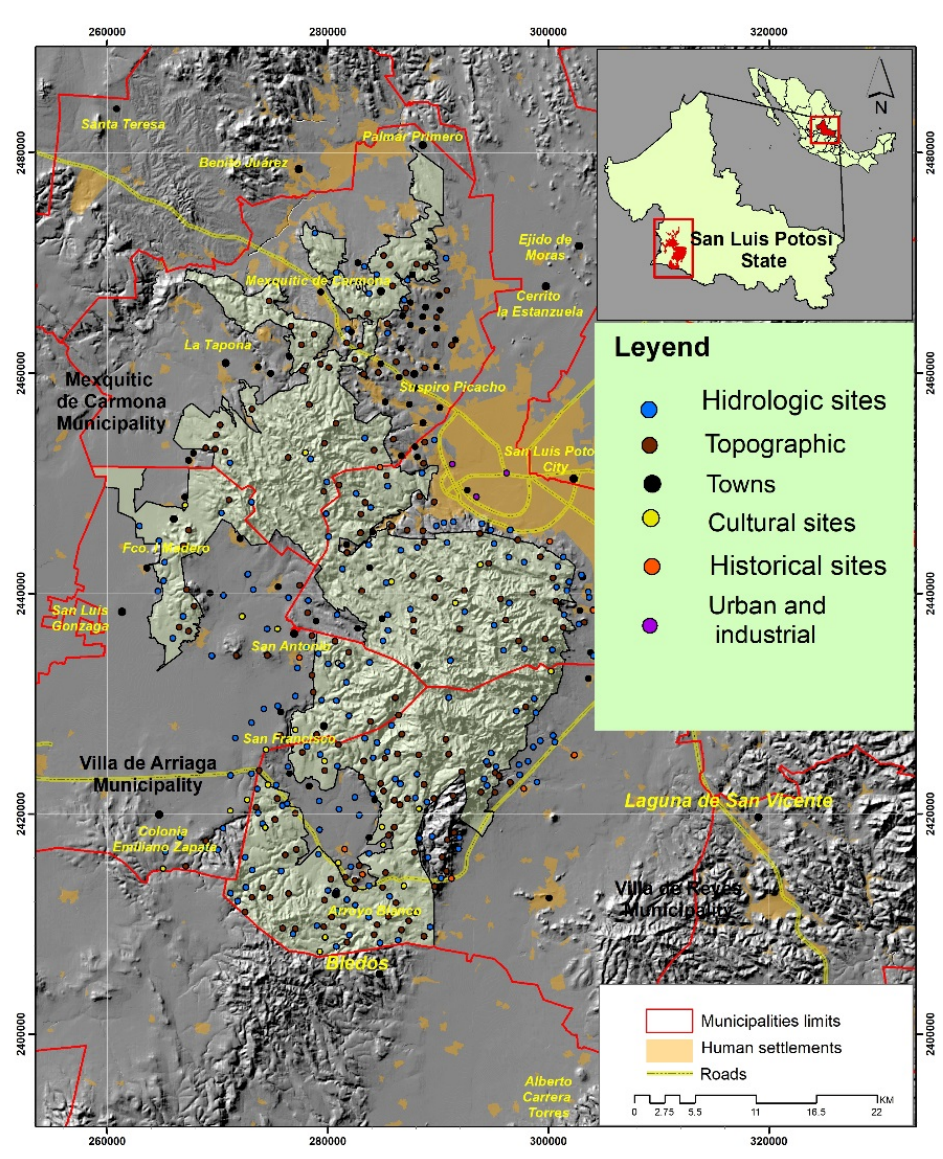
Figure 3. Map of cultural richness, Sierra de San Miguelito, San Luis Potosí.